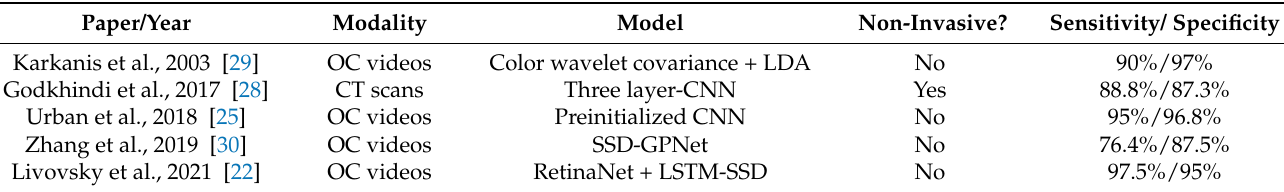
Table 2. Examples of automatic polyp detection